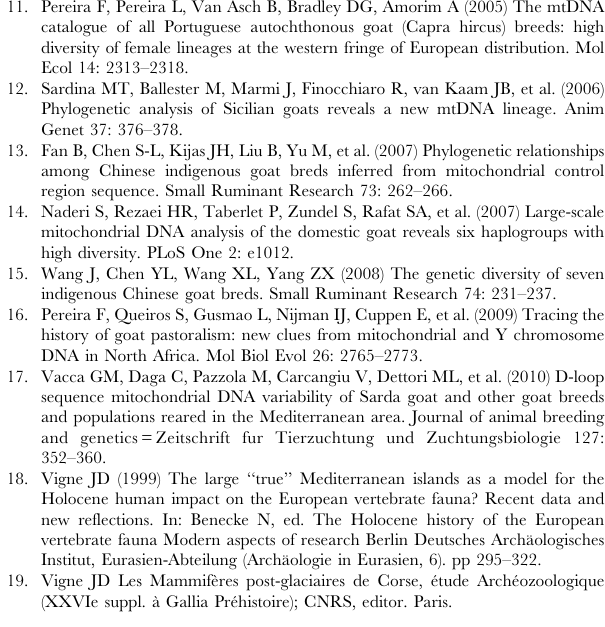
the medieval sequences (see text for details). X-axis: Time in years; Y-axis: Population size (Ne t ) in log-scale. Mean is plotted with the 95% HPD. 3 runs of 100 M of iterations were performed (ESS . 200 for all parameters).